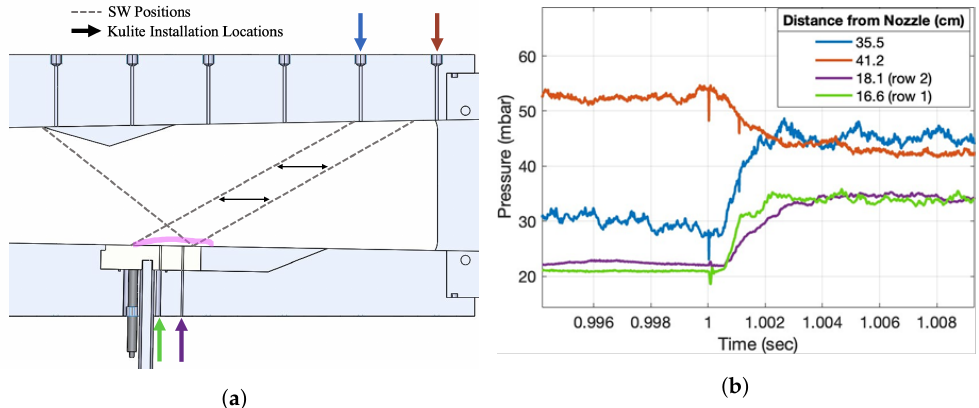
Figure 8. ( a ) Locations of pressure taps in which Kulite sensors were installed; ( b ) pressure dynamics at each location when plasma is turned on at t = 1